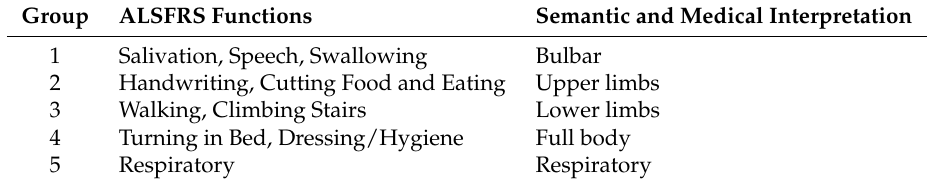
Figure 7. Correlation matrix and hierarchical clustering of ALSFRS items. Table 5. A higher level grouping of ALSFRS items based on the dendrogram of Figure 7 as is interpreted by medical